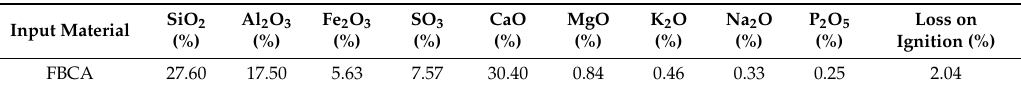
Figure 1. Clay soil ‘Cl’ from Central Europe (Brno, CZ). Table 1. Chemical composition of fluidized bed combustion fly ash